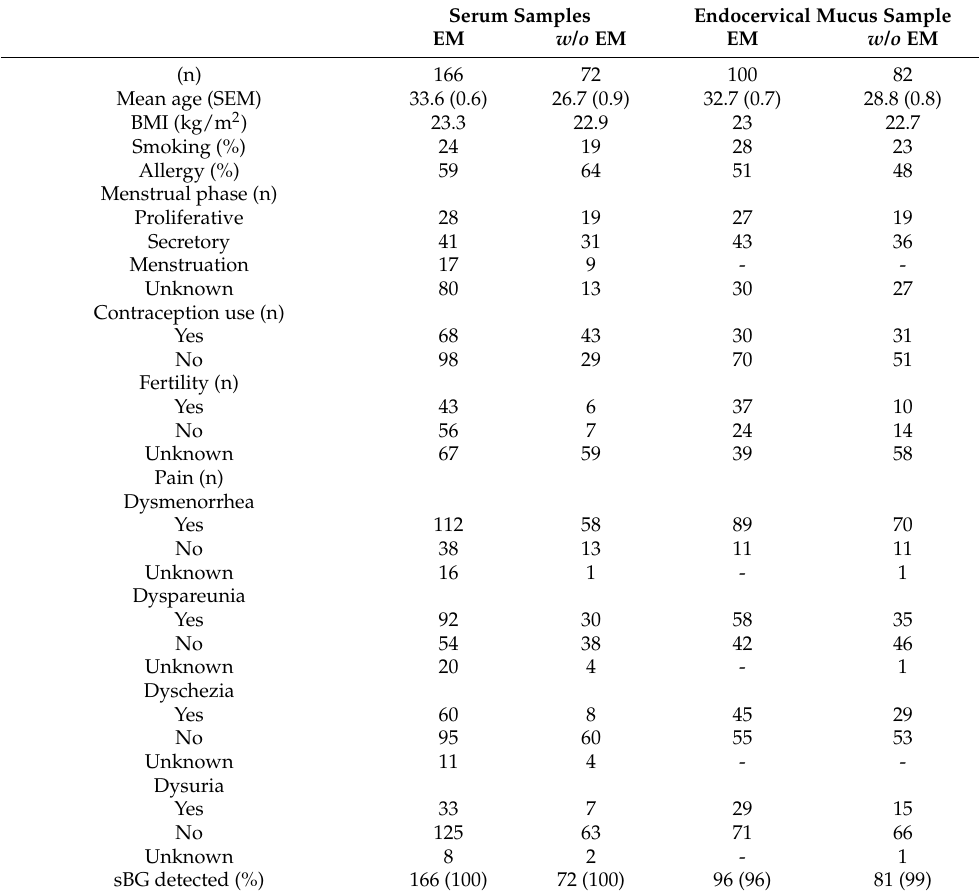
Table 2. Patient demographics and clinical